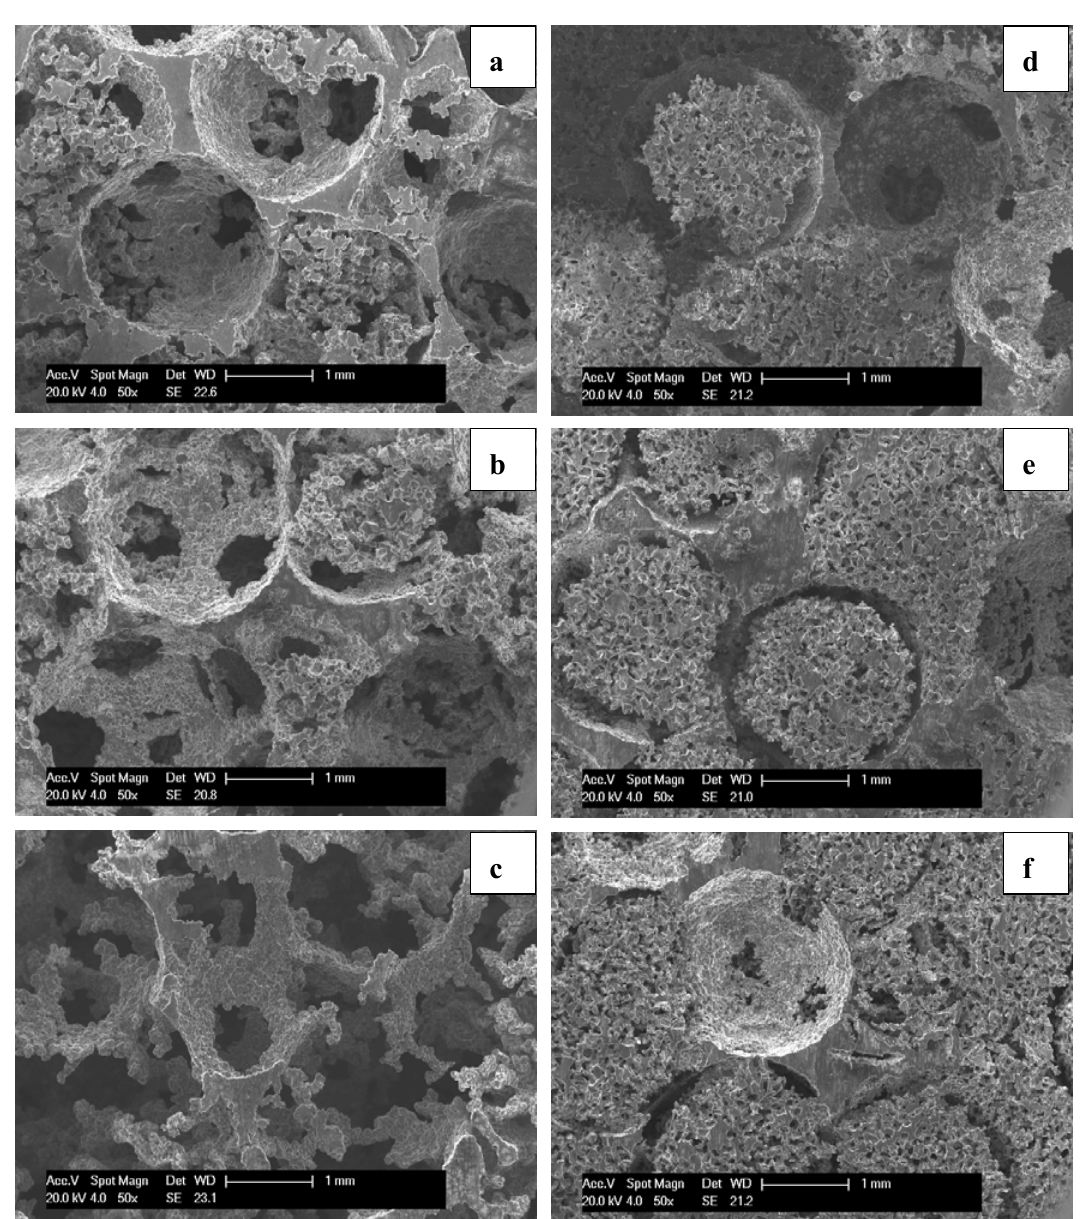
Figure 4. SEM images of infiltration in 2.5–3.1 mm bead preforms compacted at ( a ) 32 MPa; ( b ) 39 MPa; and ( c ) 50 MPa at 1 bar; and ( d ) 32 MPa; ( e ) 39 MPa and ( f ) 50 MPa at 2.5